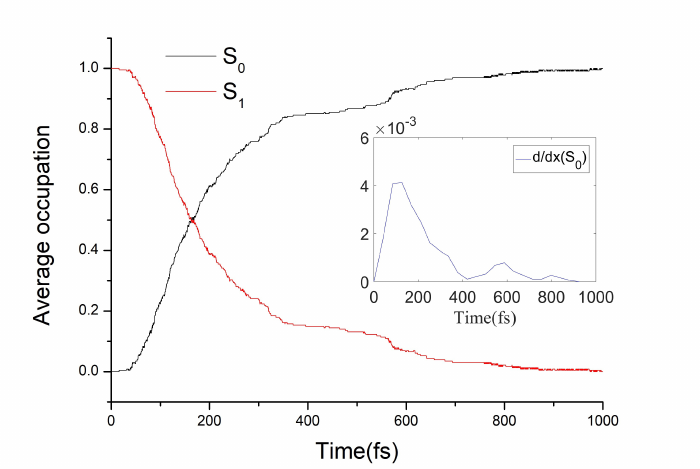
Figure 5. Average occupation of the electronic states S 0 and S 1 as a function of simulation time. Population decay with the derivative of the S 0 population is shown in the